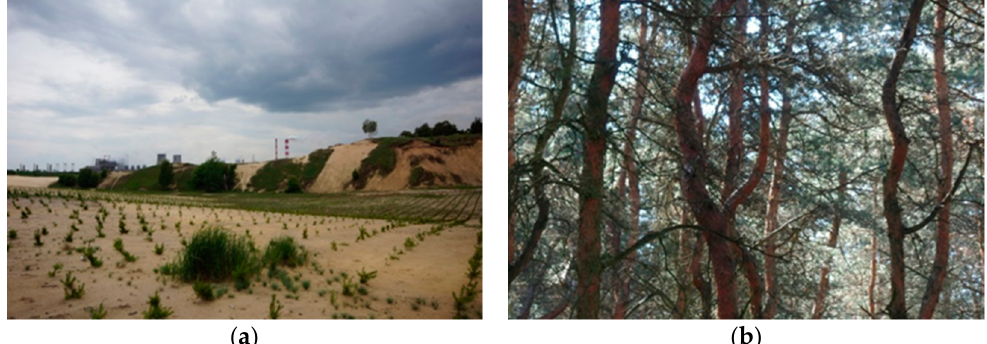
Figure 2. Landscape after the cleared Scots pine stand which has been devastated ( a ) and its crooked trunks and deformed crowns ( b ) formed as a result of the impact of Zak ł ady Azotowe Pu ł awy.